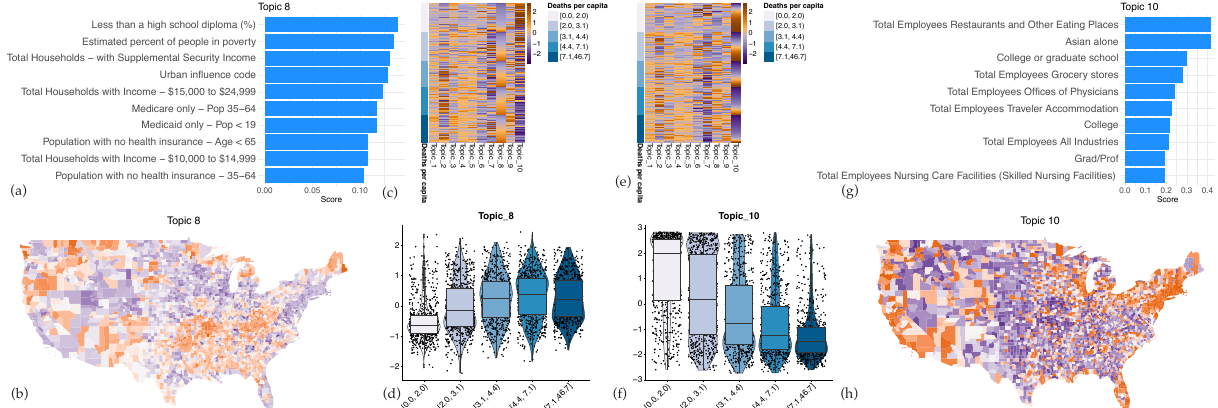
Figure 4. Topic modeling identifies associations between sets of spatial features and COVID-19 dynamics. ( a ) Top 10 feature scores for features associated with topic 8. ( b ) Topic 8 scores for each county in the US. Legend of the map is the same as the topic score heatmaps given in ( c , e ). ( c ) Heatmap of each county z-scored topic score against the mean deaths during the nationwide phase, binned into quintiles. To highlight the relationships between topic scores and deaths, the heatmap is sorted by topic 8. ( d ) Boxplot of topic scores for each county across death quintiles for topic 8, showing positive correlation with death counts. ( e ) Heatmap of each county z-scored topic score against the mean deaths during the nationwide phase, binned into quintiles. In order to highlight the relationships between topic scores and deaths, the heatmap is sorted by topic 10. ( f ) Boxplot of topic scores for each county across death quintiles for topic 10, showing negative correlation with death counts. ( g ) Top 10 feature scores for features associated with topic 10. ( h ) Topic 10 scores for each county in the US. Legend of the map is the same as the topic score heatmaps given in ( c , e